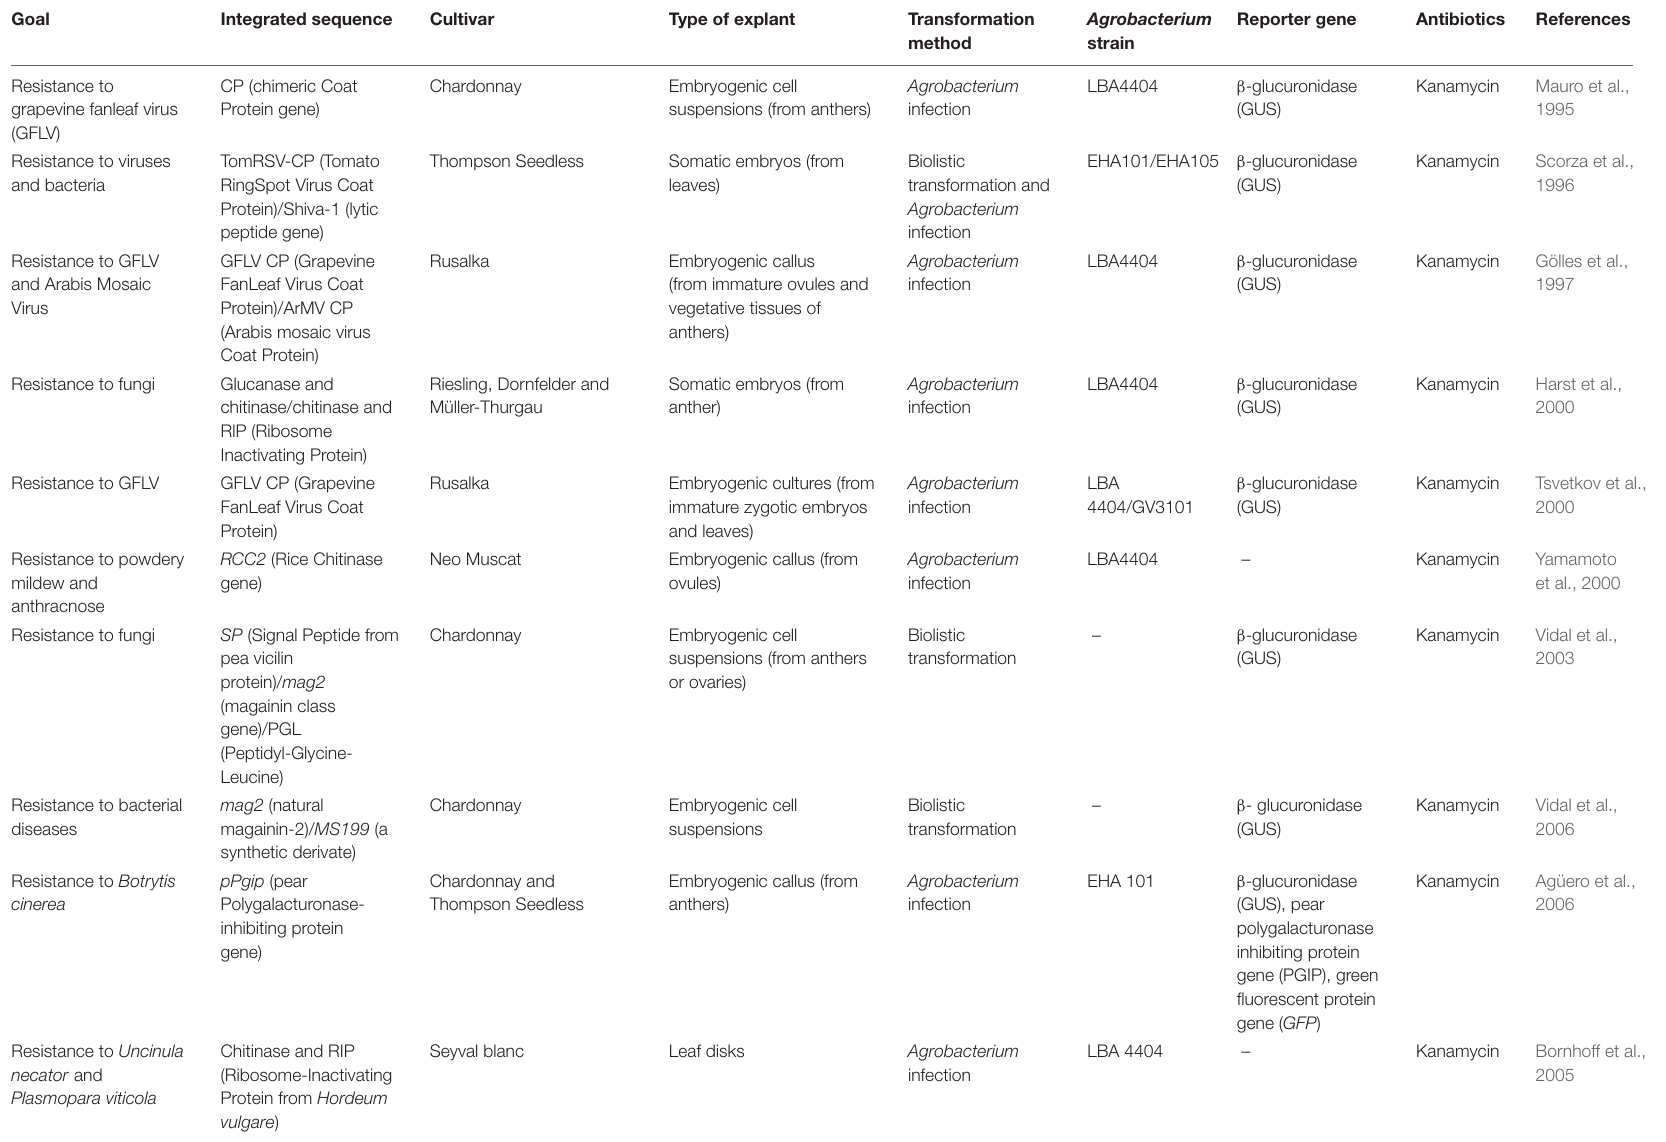
TABLE 1 | Genetic transformation works focused on the incorporation of genes related to fungal, bacterial, viral resistance, abiotic stresses, and other pathogens in V. vinifera